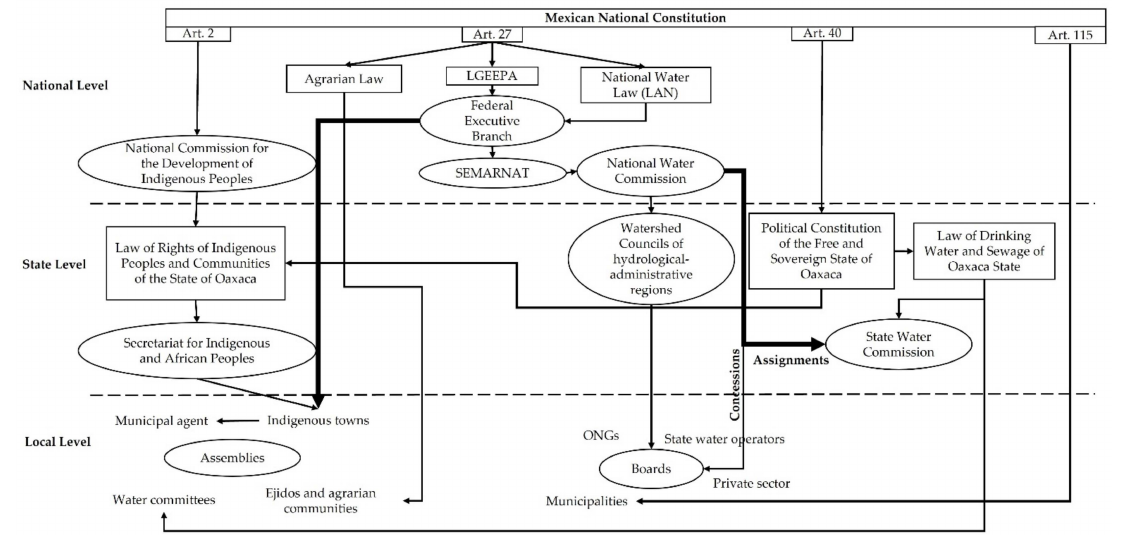
Figure 4. The multi-level structure of the governance of the water supply system for domestic use in Mexico. The squares and circles refer to the laws (institutions) and stakeholders (circles), respectively. Arrow thickness only serves to differentiate among arrows when they intersect. LGEEPA: Ley General del Equilibrio Ecologico y la Protecci ó n al Ambiente. SEMARNAT: